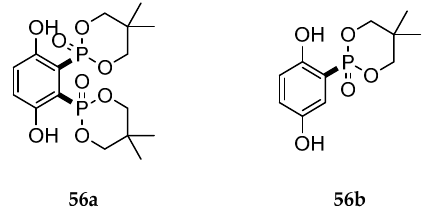
Figure 26. Phosphonate derivatives 56a and 56b .